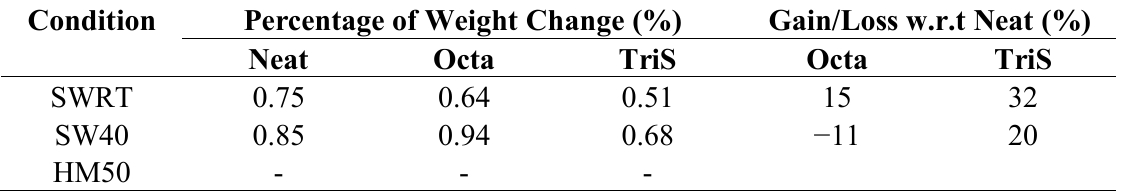
Table 3. Comparison of weight change in moist and saltwater